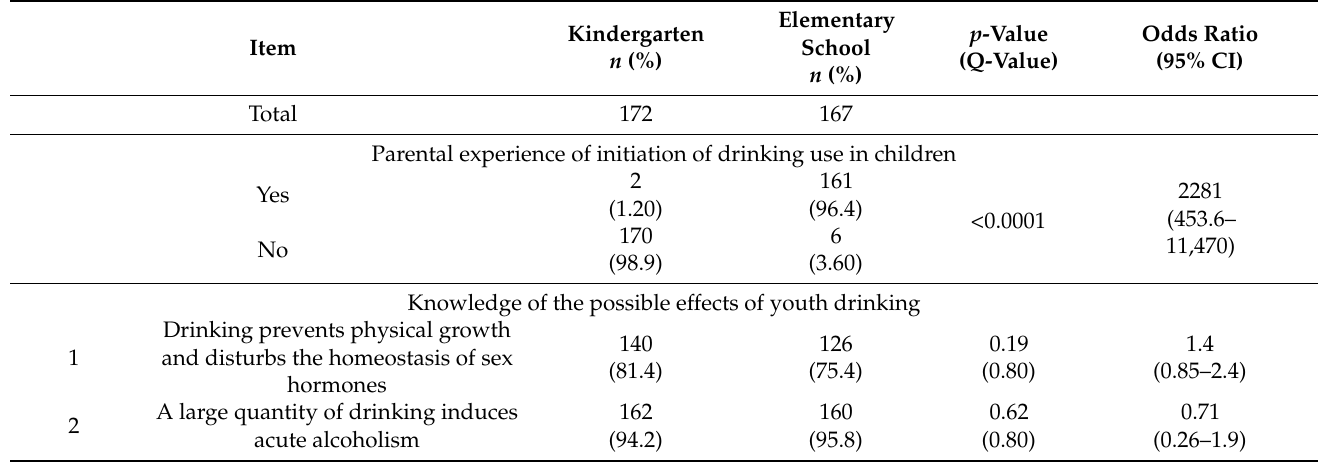
Table 2. Comparison of parents of kindergarten and elementary